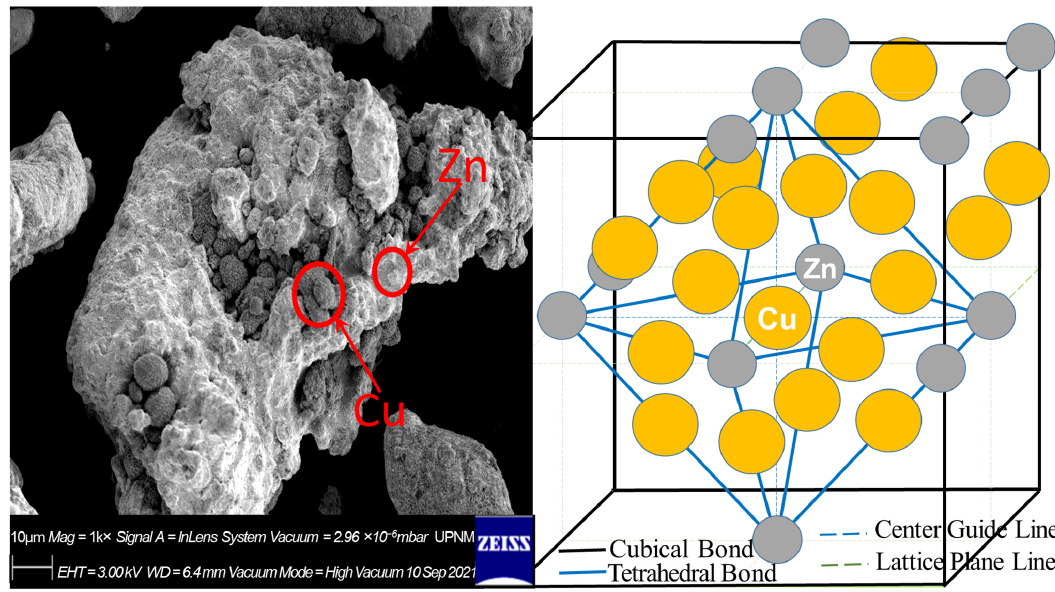
Figure 5. Morphology comparison between the low brass’s micrograph and the Cu-Zn superlattice structure class’s illustration.